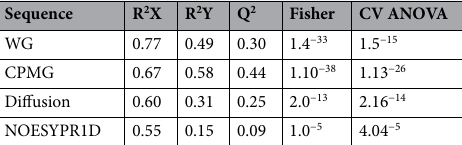
Table 2. Characteristics of the OPLS-DA models obtained to differentiate between